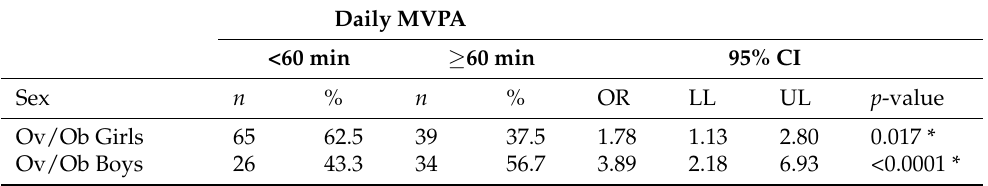
Table 2. Prevalence of meeting MVPA criteria and the relevant odds ratios for girls and boys, respectively. Daily MVPA <60 min ≥ 60